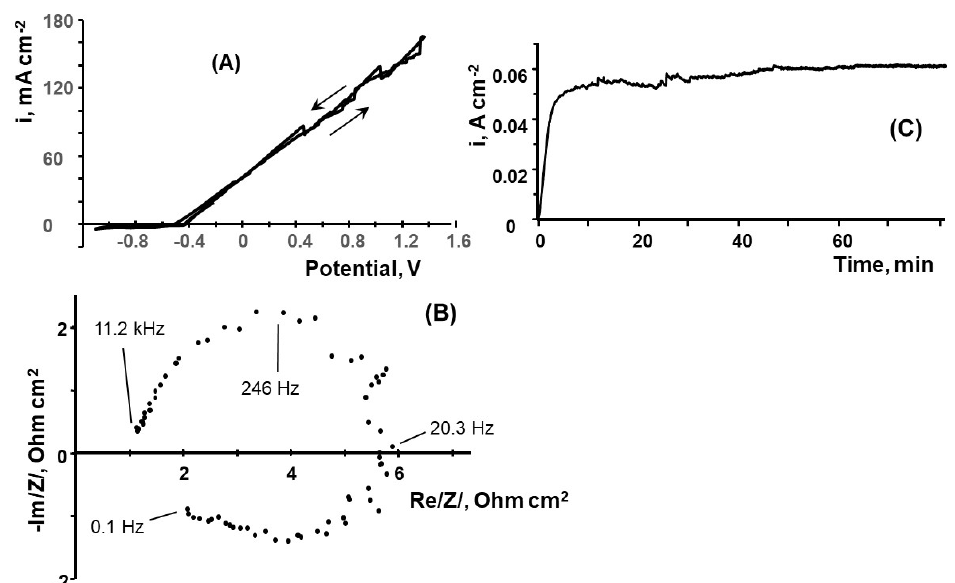
Figure 5. ( A ) Voltammetry of the Al electrode at 25 °C in a 0.5 M NaCl electrolyte. A potential scan was initiated at E = − 1.1 V at a scan rate of 2 mV s − 1 . ( B ) Nyquist plot of the EIS measurements with the Al electrode at E = − 0.4 V in 0.5 M NaCl at 25 °C. ( C ) Al electrodissolution at E = − 0.4 V in 0.5 M NaCl at 40 °C.